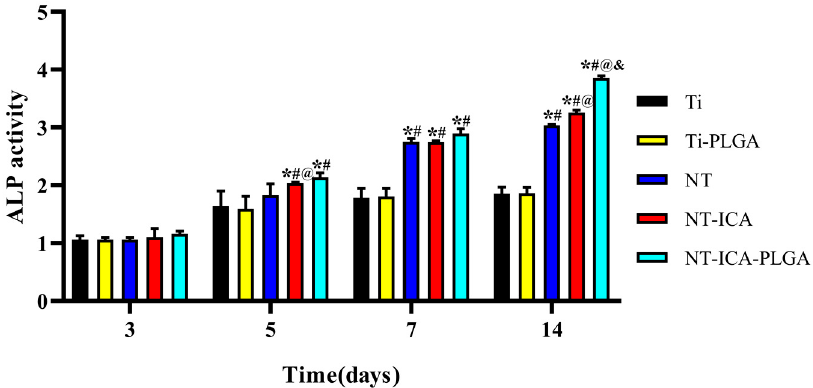
Figure 8. ALP activity of MC3T3-E1 cells on different surfaces after 3, 5, 7 and 14 days. * indicate statistical significance compared to Ti, # indicate statistical significance compared to Ti-PLGA, @ indicate statistical significance compared to NT and & indicate statistical significance compared to NT-ICA group ( p < 0.05). The values were calculated as mean ± standard deviation, n = 3. The experiments were repeated three times.